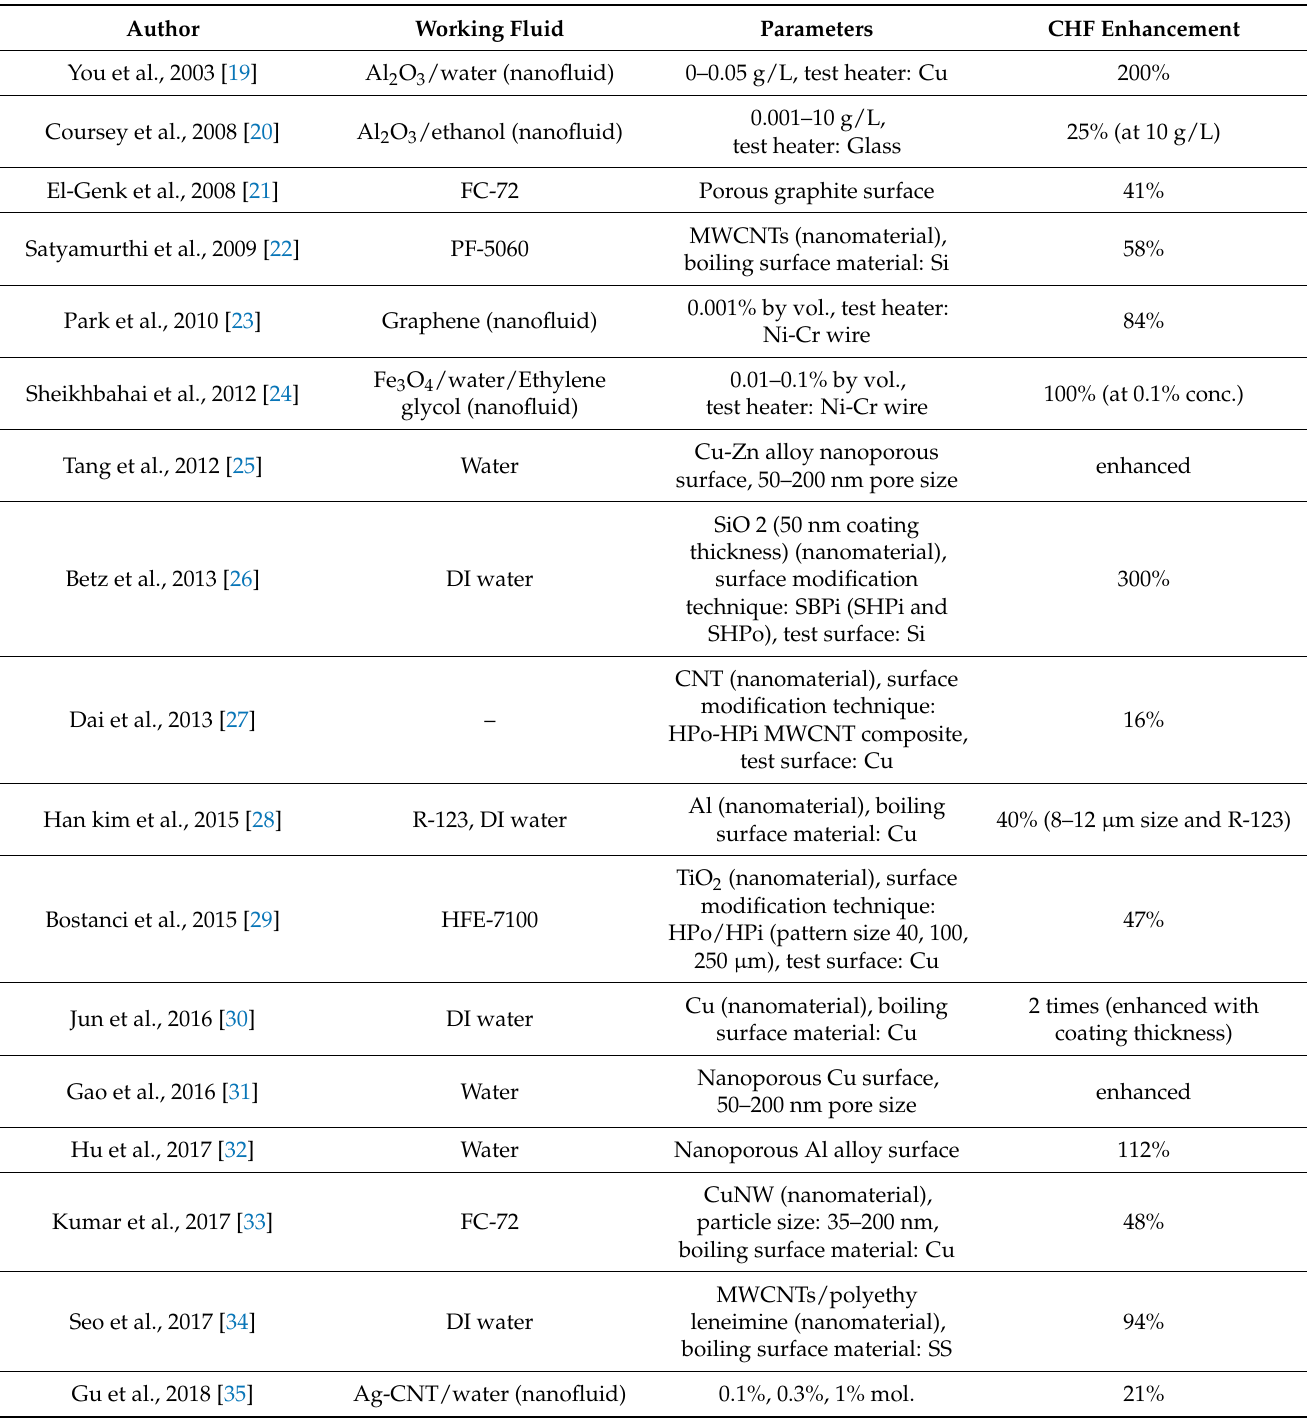
Table 1. Comparative study of different approaches of heat transfer